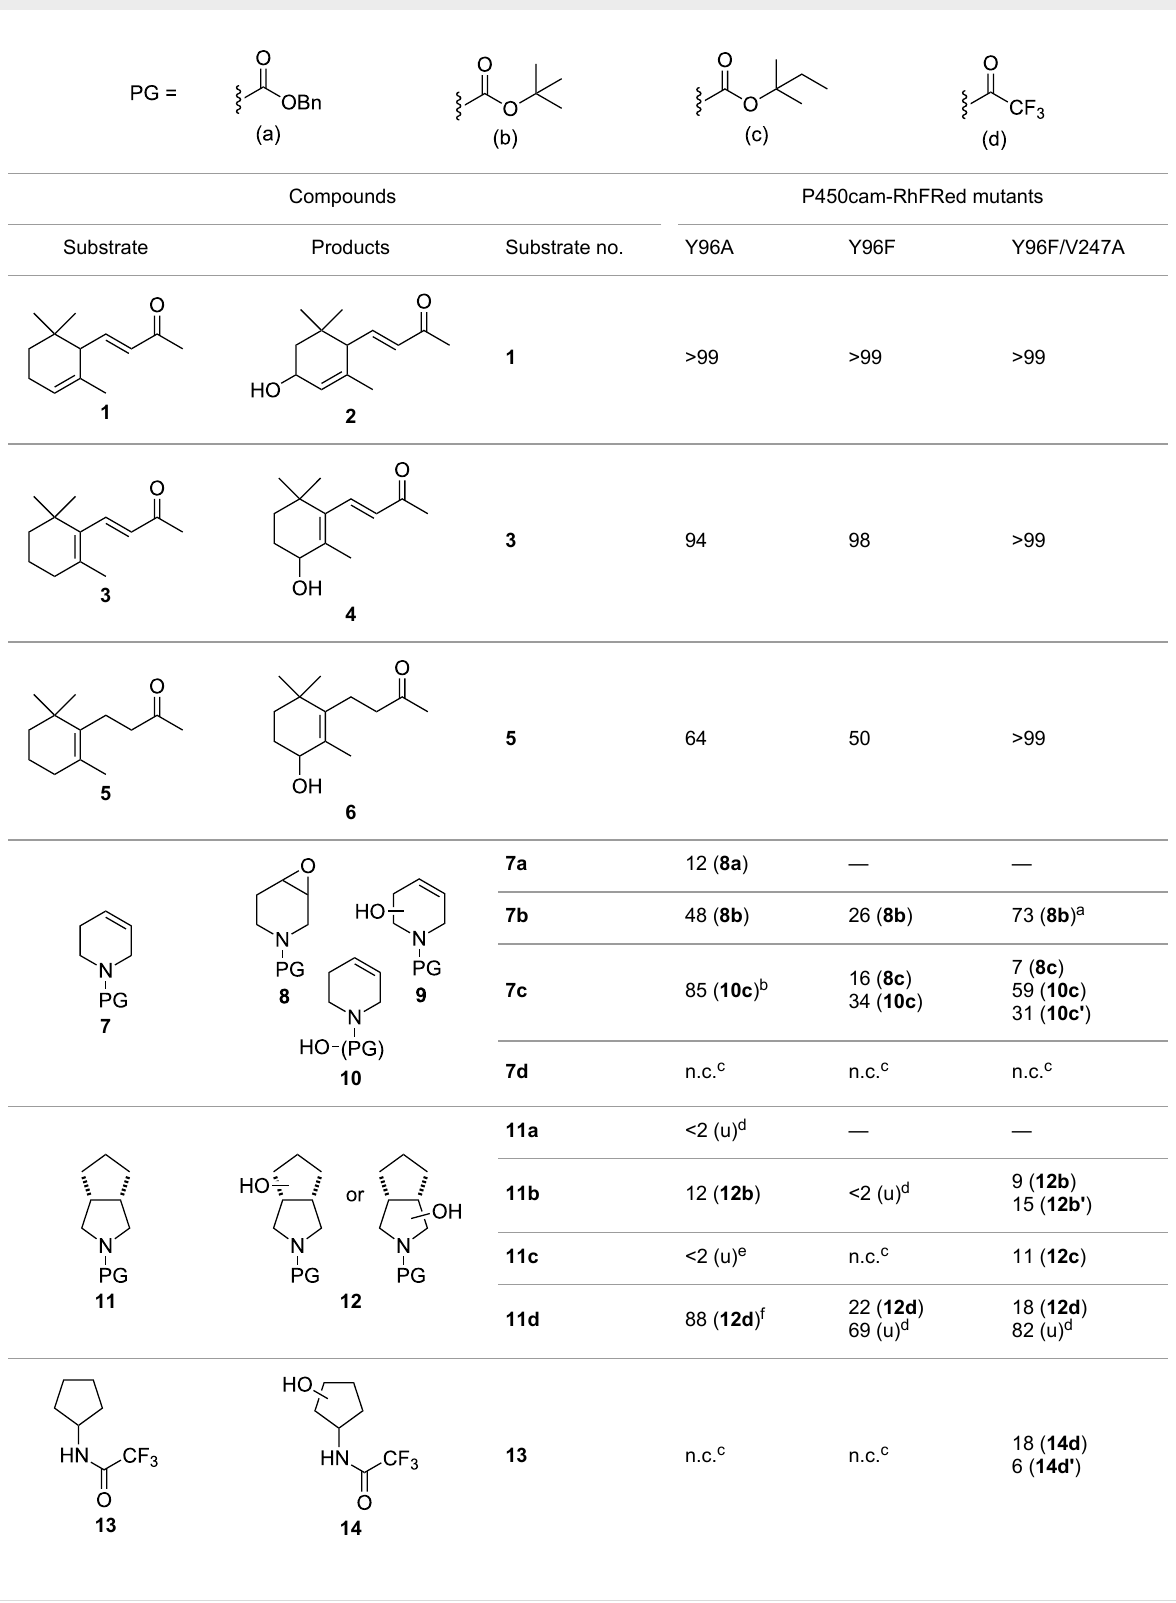
Compounds P450cam-RhFRed mutants Substrate Products Substrate no. Y96A